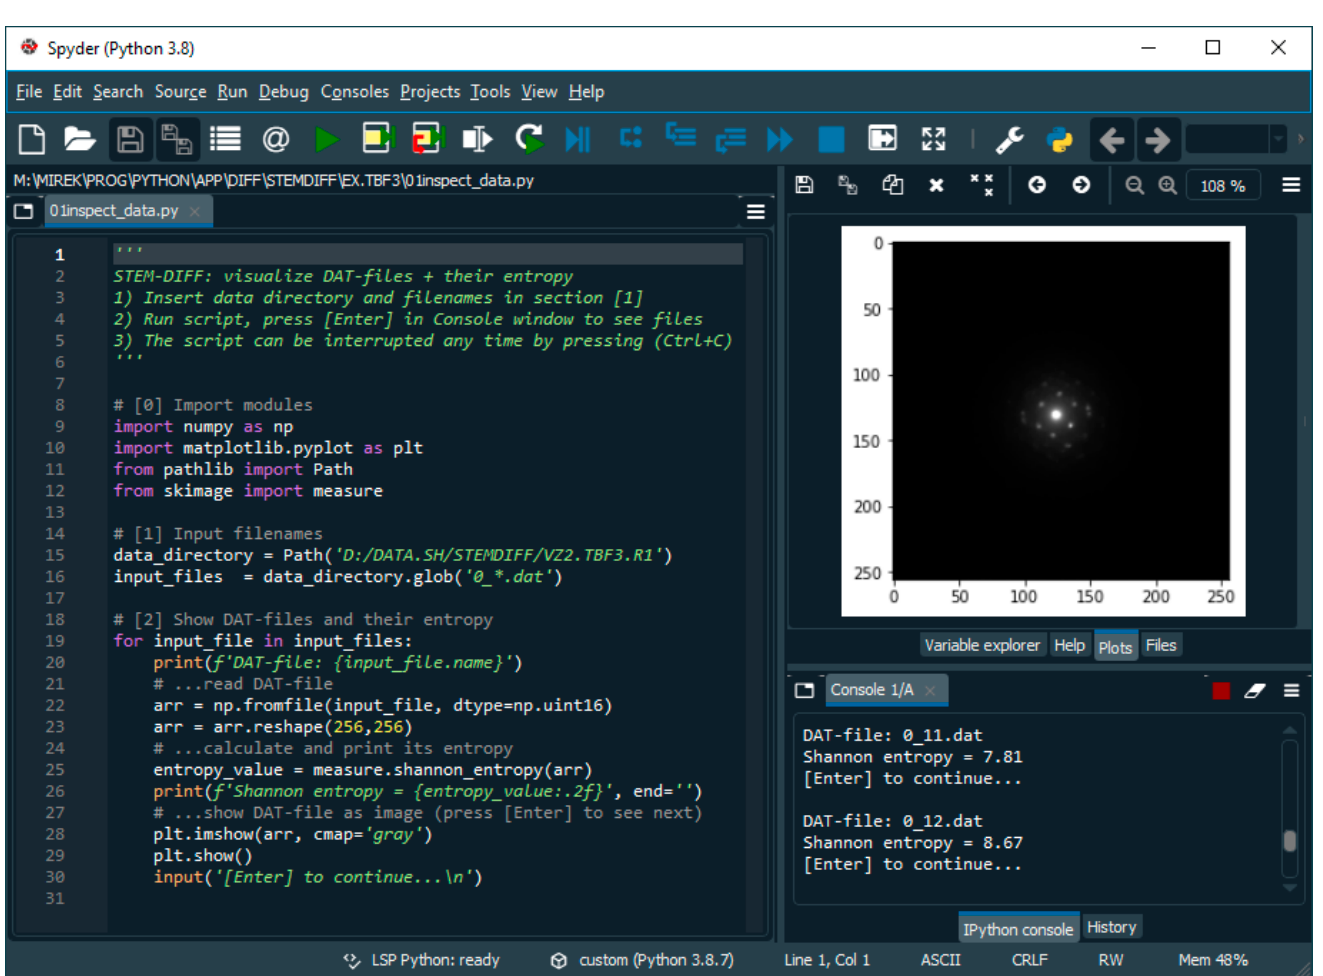
Figure 7. User interface of program package STEMDIFF is based on Spyder (freeware Scientific Python Development Environment). Selected script (here: inspect-data.py ) is opened in the editor window (leftmost window) and slightly modified according to the description in its header (here we just define the names of input files). After running the script (Menu → Run), we can see image outputs (here: individual diffraction patterns) in the plot window (upper right) and numerical outputs (here: current file name and corresponding value of Shannon entropy) in the console window (lower right).